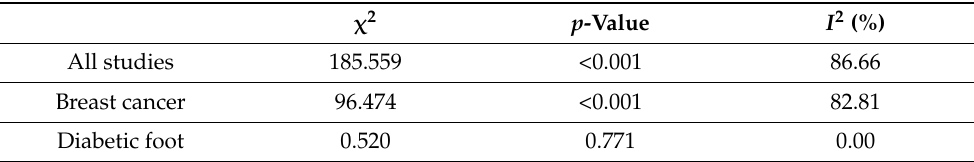
Table A2. Test for heterogeneity with χ 2, respective p -values and I2 for all studies combined, as